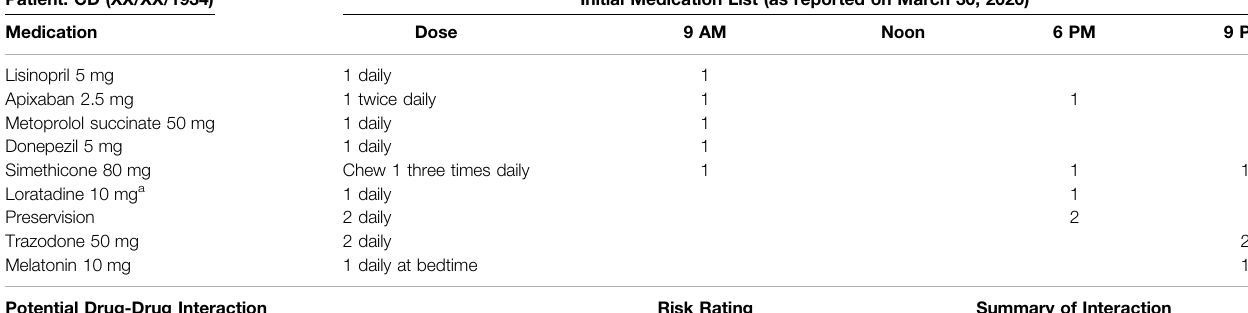
TABLE 1 | Initial Medication List (as reported on March 30, 2020) Patient: CD